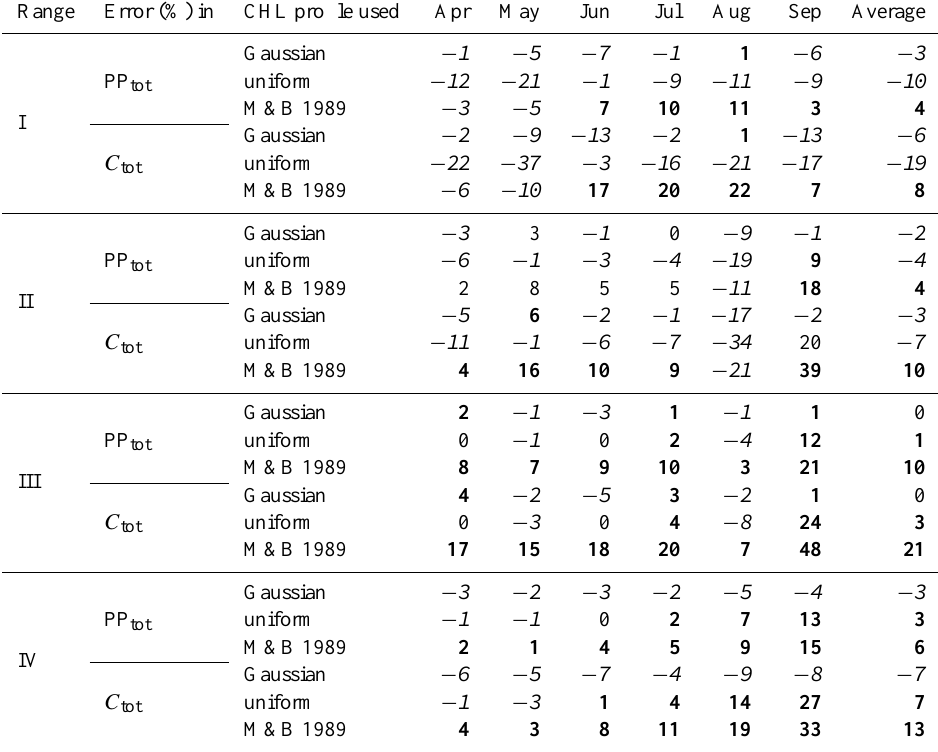
Table 2. Relative errors in the total PP and CHL content in the water column (PP tot and C tot respectively). PP tot and C tot inferred from in situ CHL profiles are used as a reference, and are compared to C tot and PP tot inferred using (1) mathematical Gaussian fits of this study; (2) uniform CHL profiles; and (3) Morel and Berthon (1989) profiles. C tot and PP tot are integrated until the euphotic depth estimated following Morel (1988). PP is proportional to square root of CHL following Eppley et al. (1985). Overestimations of the in situ values are in bold